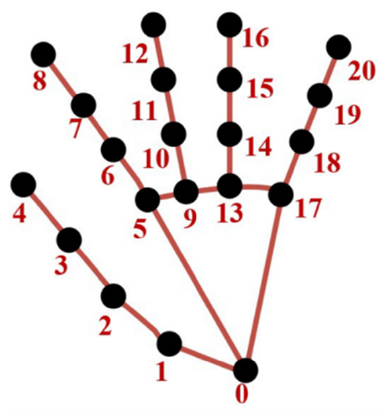
Figure 1. MediaPipe hand landmarks. Table 2. Descriptions of MediaPipe landmarks.